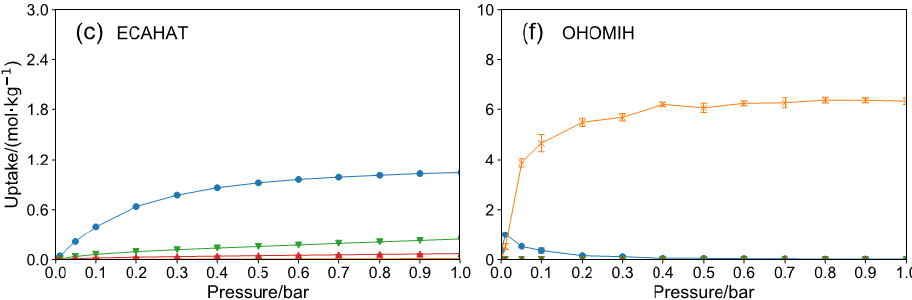
Figure 7. HCHO, H 2 O, N 2 , and O 2 adsorption isotherm of top-performing henry constant selectivity MOFs ( a ) JAVTAC, ( b ) WOJJOV, ( c ) ECAHAT, ( d ) DORDUK, ( e ) DOTTUC, ( f ) OHOMIH for a mixture component of HCHO/H 2 O/N 2 /O 2 = 200/3280/77,216/19,304 from GCMC simulation at 298 K.